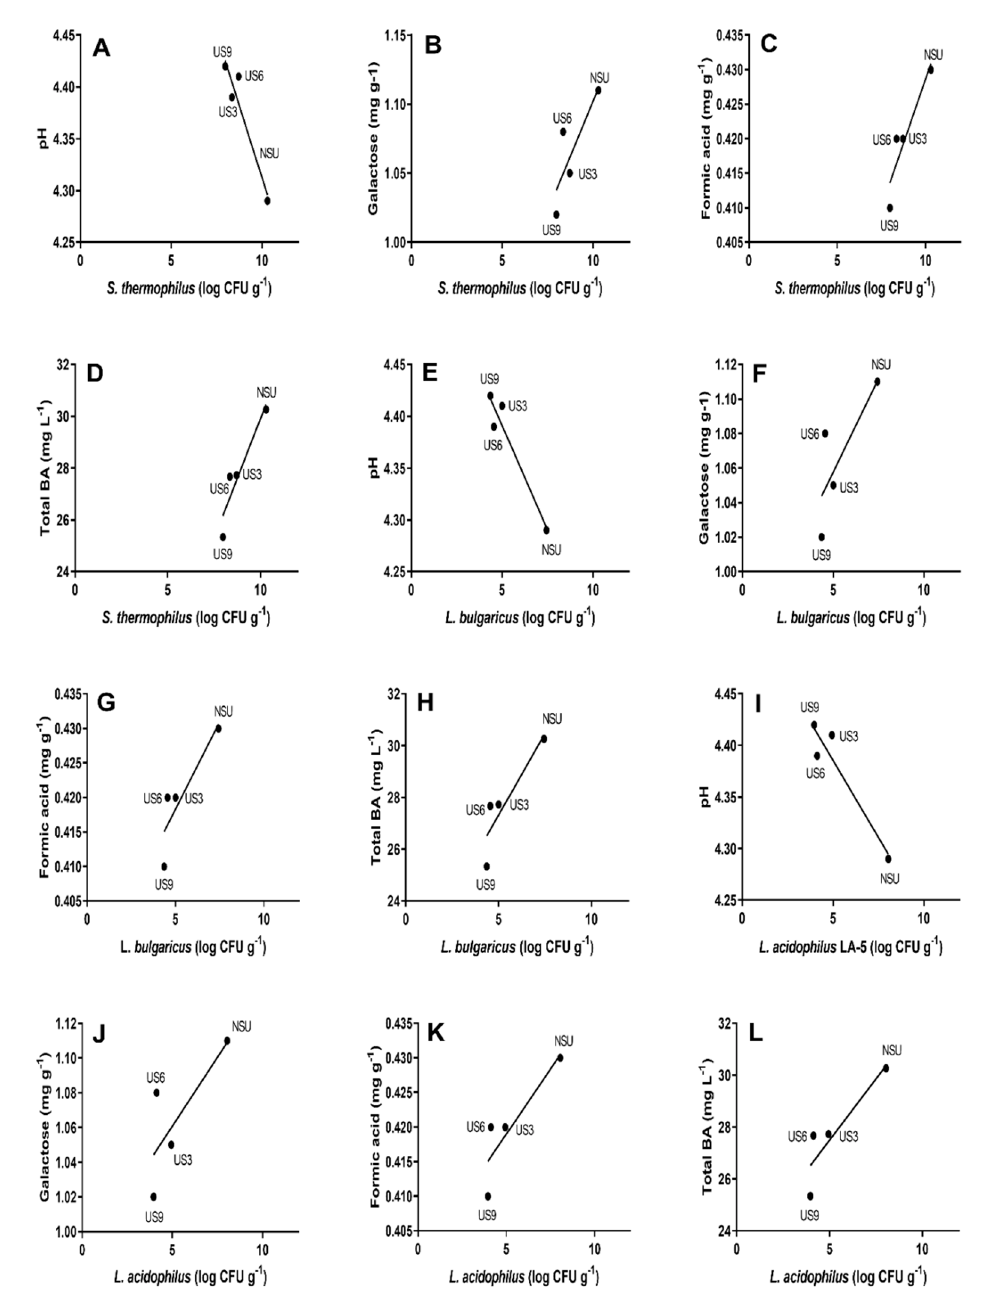
Figure 1. Significant correlations ( p < 0.05) were internally validated by the bootstrap method between physicochemical and microbial parameters for goat milk yogurt stored at 4 °C. ( A – D ) Streptococcus thermophilus ; ( E – H ) Lactobacillus delbrueckii ssp. bulgaricus ; ( I – L ) Lactobacillus acidophilus LA-5. NSU, non-sonicated goat milk yogurt; US3, goat milk yogurt sonicated for 3 min; US6, goat milk yogurt sonicated for 6 min; US9, goat milk yogurt sonicated for 9 min; total BA, total biogenic amines.